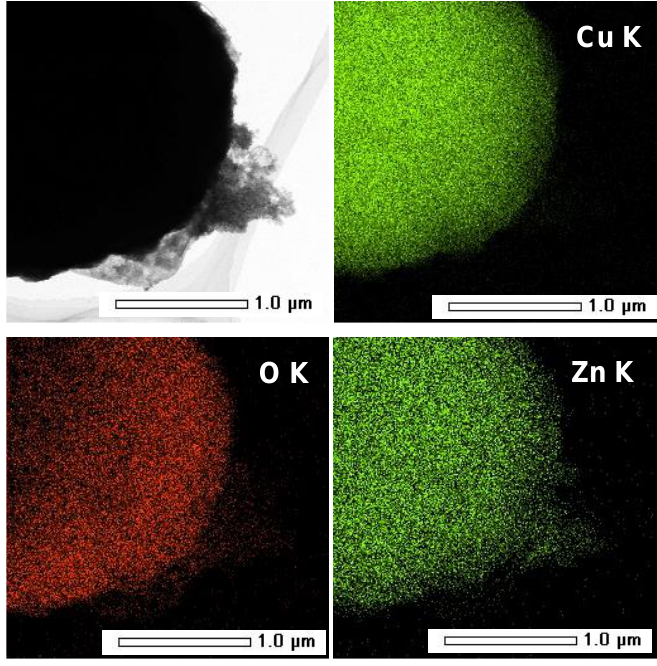
Figure 7. STEM image with elemental mapping of sample S6.